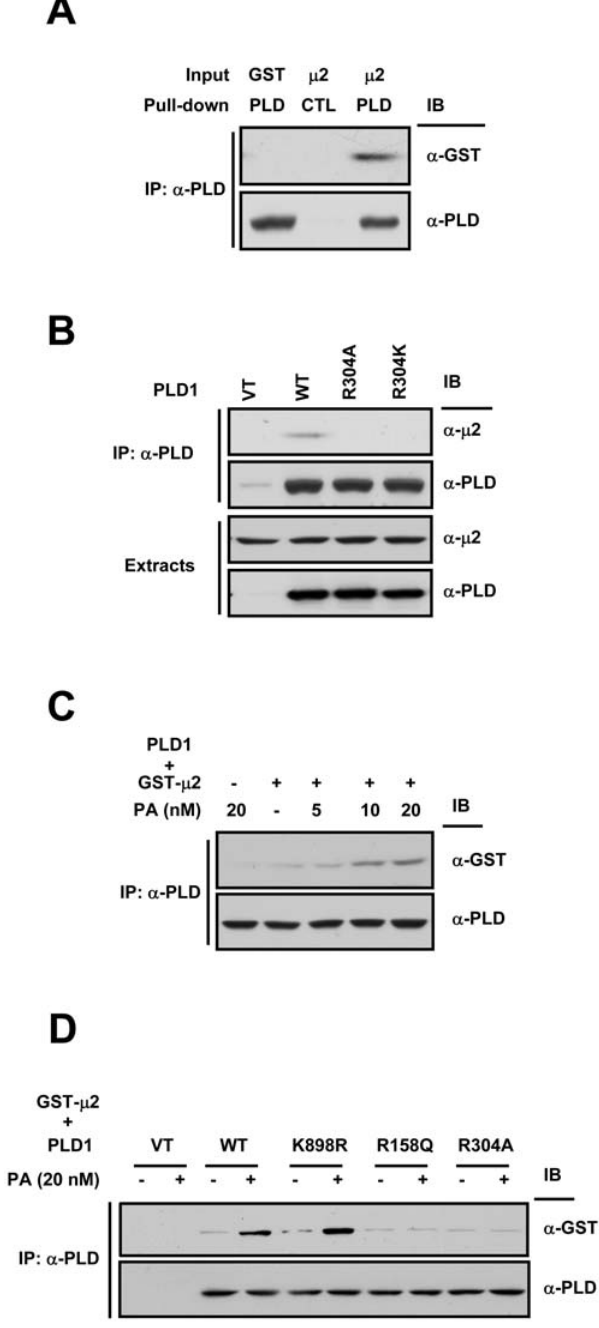
Figure 3. Association with PA enhances the direct interaction between PLD1 and m 2. (A) Purified PLD1 immobilized with anti-PLD antibody (PLD) or with pre-immune serum (CTL) was incubated with purified GST alone or GST- m 2. (B) HeLa cells expressing vector, wild type, R304A, or R304K PLD1 were grown in DMEM containing 10% fetal bovine serum. Cells were lysed and immunoprecipitated with anti-PLD antibody. (C) Purified PLD1 immobilized with anti-PLD antibody was incubated with purified GST alone or GST- m 2 in the absence or presence of C6-PA at the indicated concentrations. (D) Vector, wild type, K898R, or R158Q PLD1 transiently expressed in HeLa cells was immunoprecip- itated and incubated with purified GST- m 2 in the absence or presence of 20 nM of C6-PA.